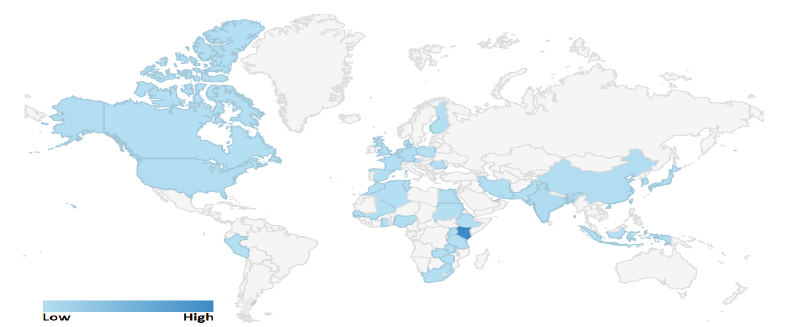
Figure 6. ODK—distribution of users globally.